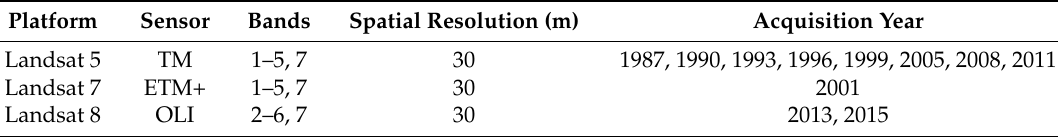
Table 1. Landsat images acquired.